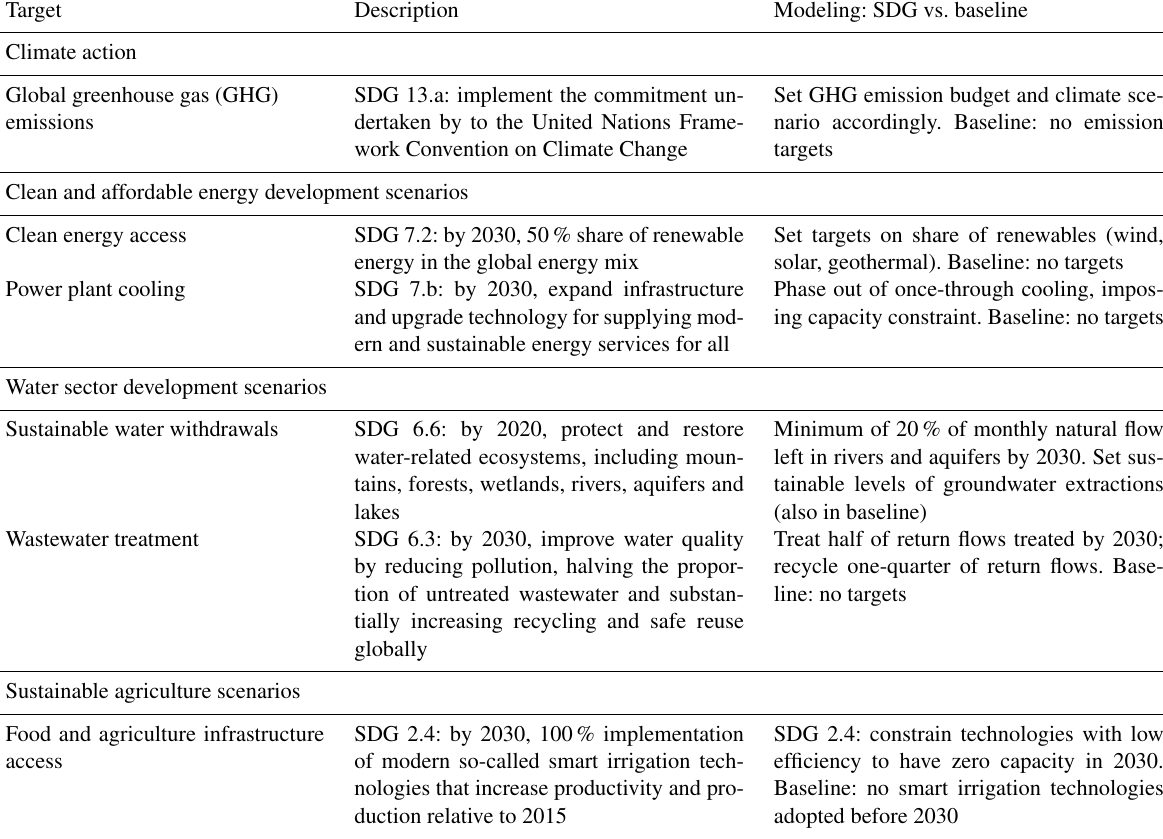
Table 3. Policy scenarios embedding specific SDG targets (SDG,